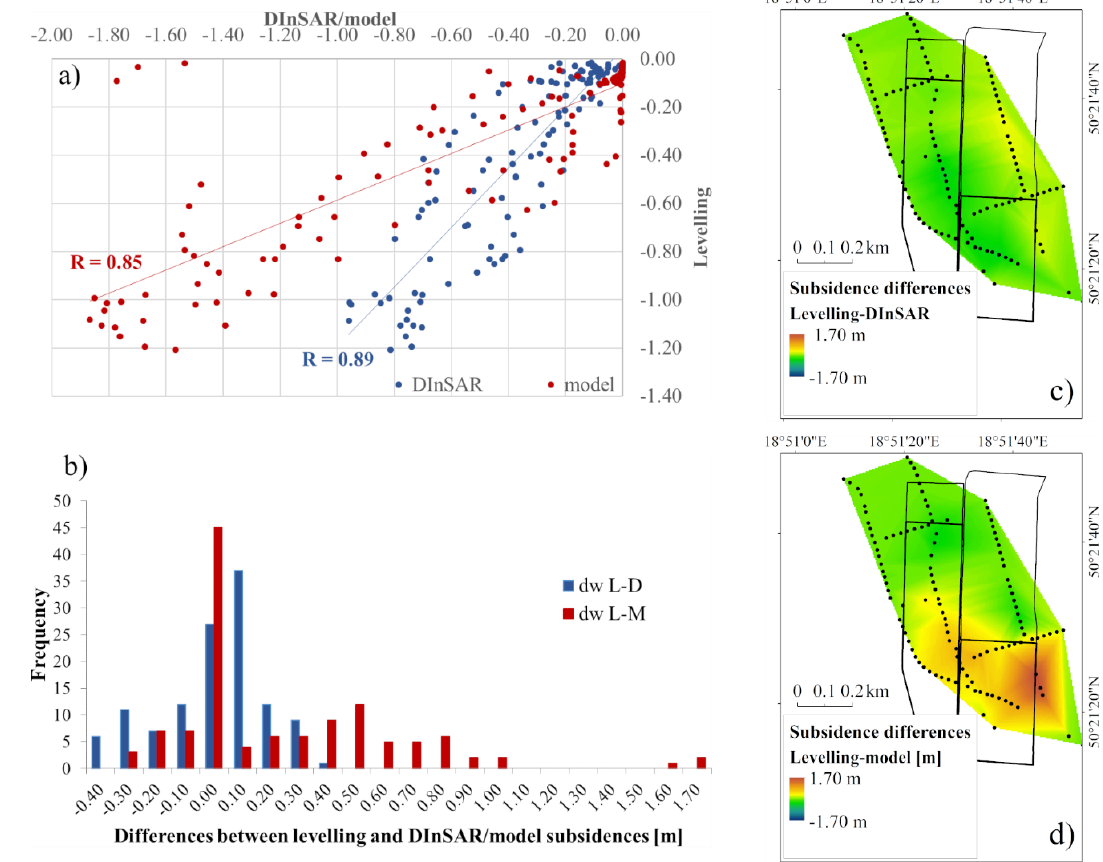
Figure 21. ( a ) Correlation between subsidence from the levelling (vertical axis) and DInSAR (blue) and model (red) along the horizontal axis; ( b ) histogram of the distribution of errors between subsidence derived from levelling (L), DInSAR (D), and modelling (M); and fields of errors for ( c ) L-D and ( d ) L-M.